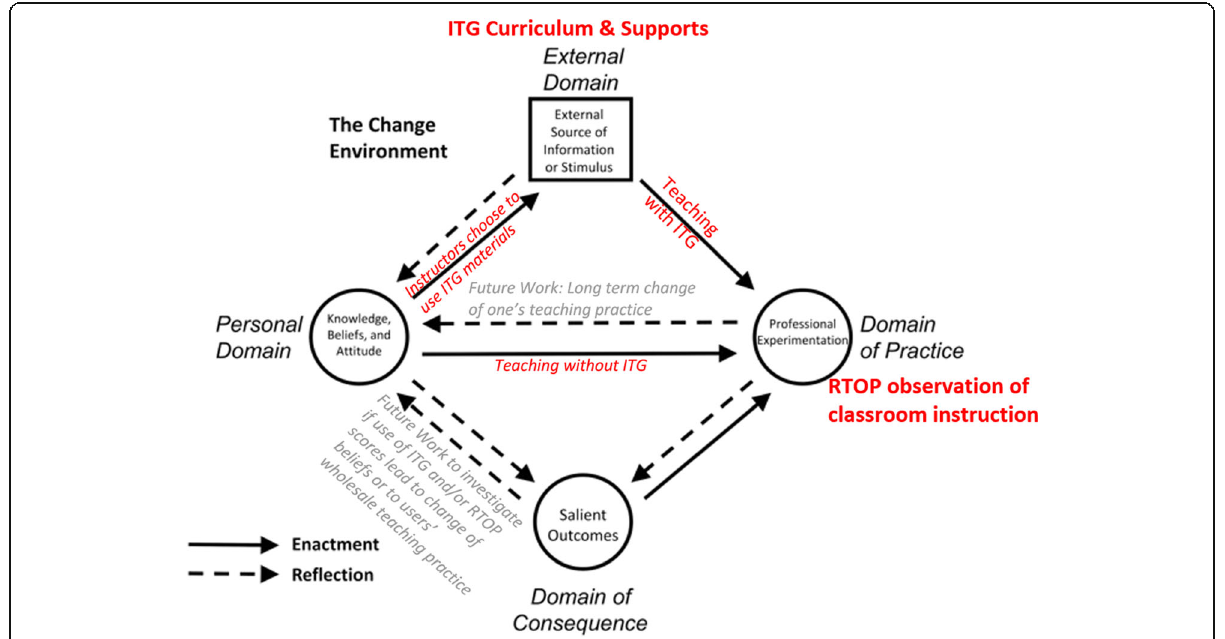
Fig. 1 The interconnected model of professional growth, recreated from Clarke and Hollingsworth (2002)